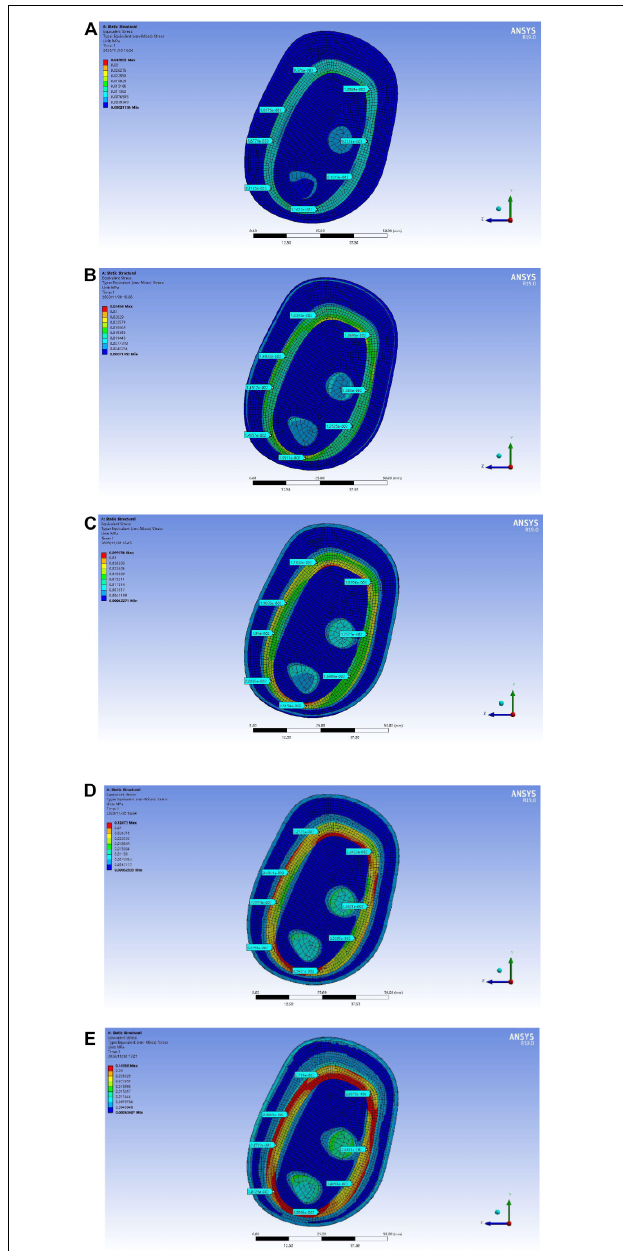
FIGURE 13 | Point selection picture of the lymph and blood layers of the upper arm model with different external pressure loads: (A) 002 MPa external